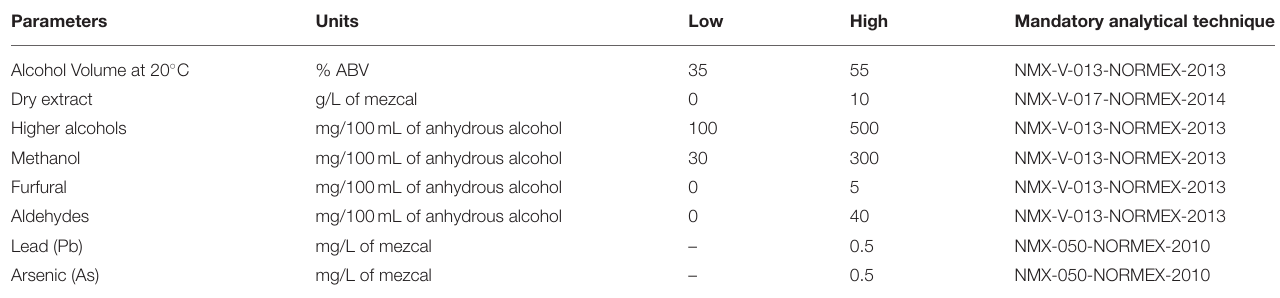
TABLE 2 | Chemical compounds regulated by the NOM and their minimum and maximum permitted levels. Parameters